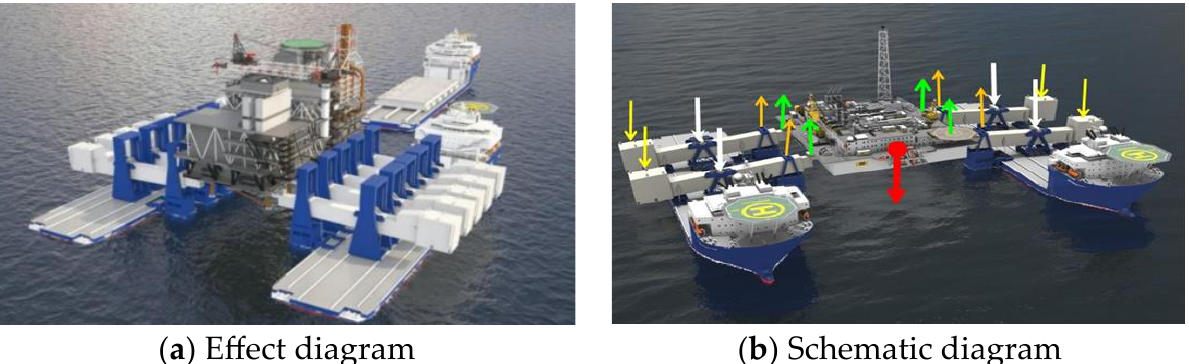
Figure 1. Effect diagram of the integrated dismantling device and schematic diagram of the hoisting principle.